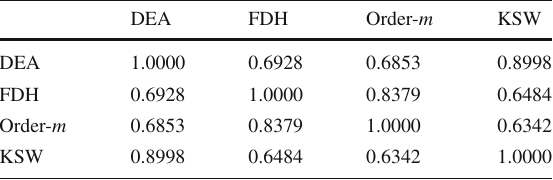
Table 8 Rank correlation Kendall coefficients between the average cost efficiency estimates of the four methodologies for